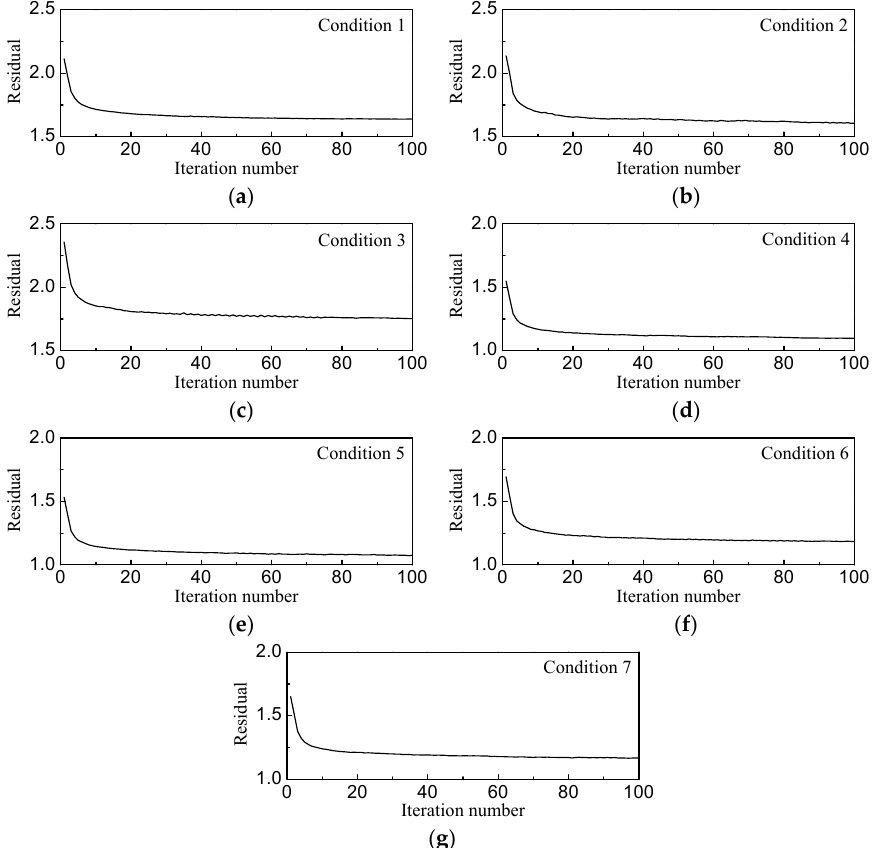
Figure 13. Reconstruction residuals during the K-SVD process: ( a ) Condition 1; ( b ) Condition 2; ( c ) Condition 3; ( d ) Condition 4; ( e ) Condition 5; ( f ) Condition 6; ( g ) Condition 7.